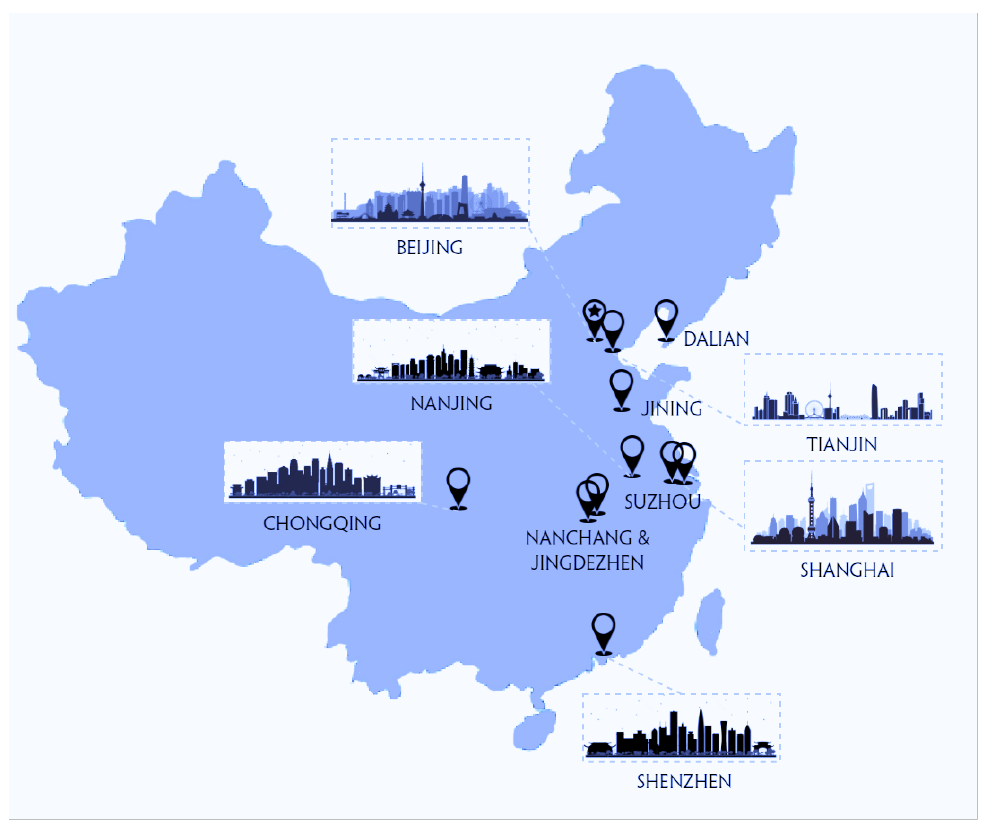
Figure 8. Geographic distribution of buildings included in the system.